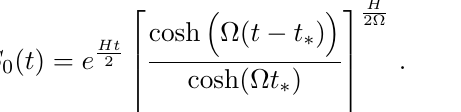
Figure 3 . (Left) Different protocols for S 0 All protocols lead to the same late-time value of E